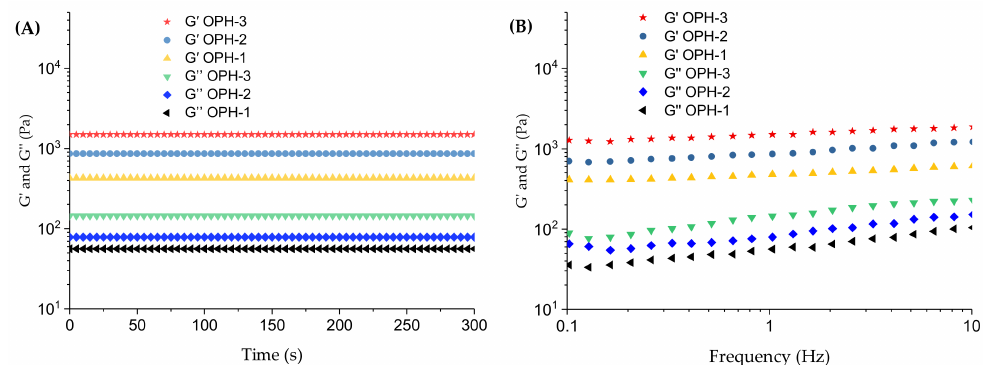
Figure 4. G (cid:48) and G (cid:48)(cid:48) of OPHs with the increase of time ( A ) and dynamic frequency from 0.1 to 10 Hz ( B